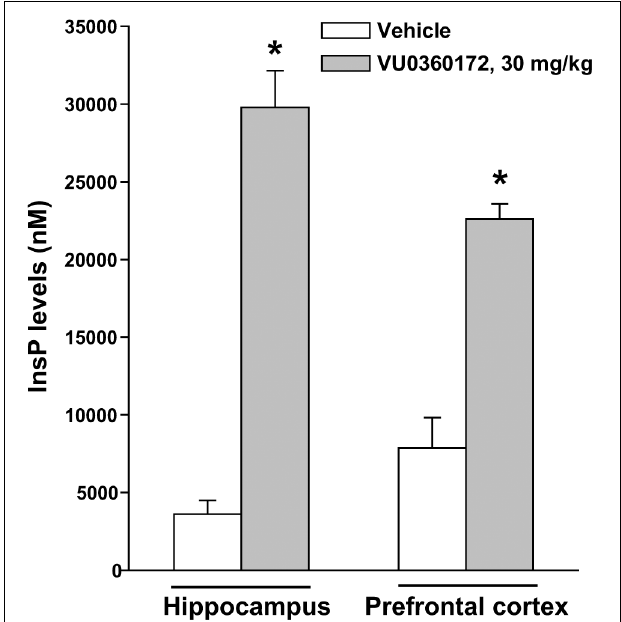
FIGURE 2 | Assessment of mGlu5 receptor-mediated PI hydrolysis in the hippocampus and prefrontal cortex of C57Black mice challenged with VU0360172. Adult C57Black mice were treated i.p. with 10 mmol/kg of lithium chloride followed by vehicle or VU0360172 (30 mg/kg). Values are means + SEM of six mice per group. ∗ p < 0.05 vs. data obtained in mice treated with vehicle in the same brain region [One-Way ANOVA + Fisher’s LSD; F ( 3 , 20 ) =